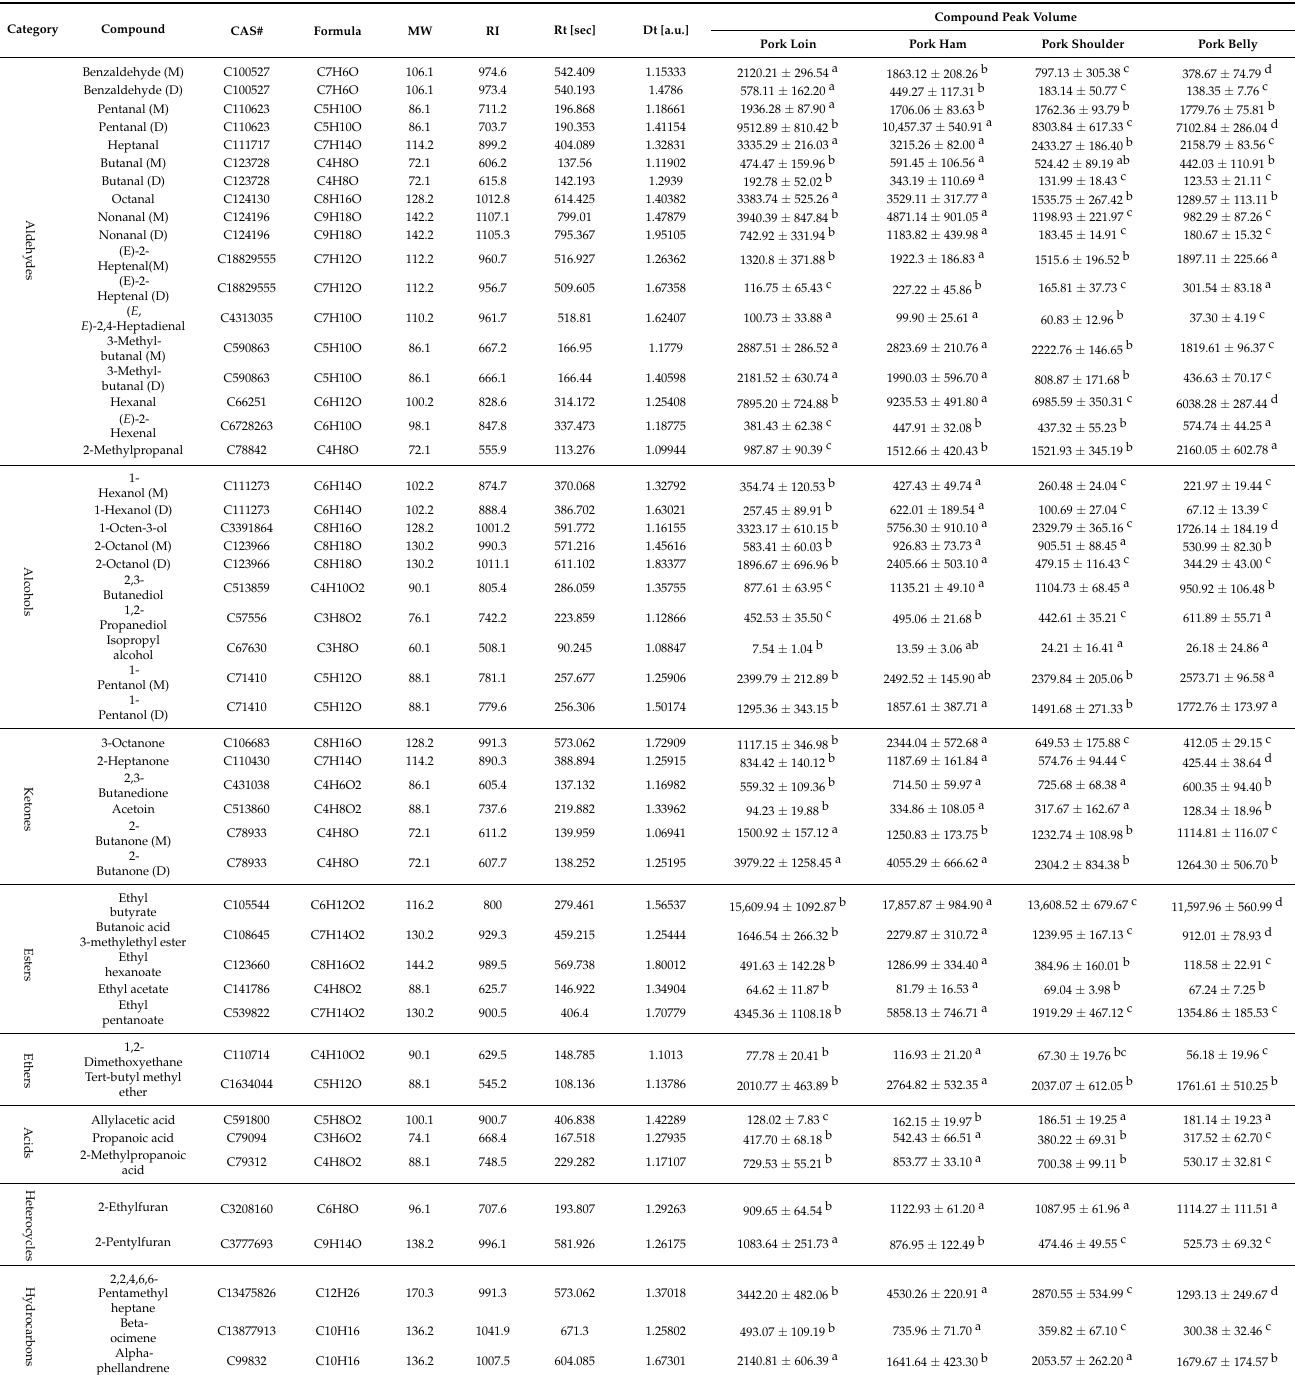
Table 1. Qualitative analysis of pork volatile organic